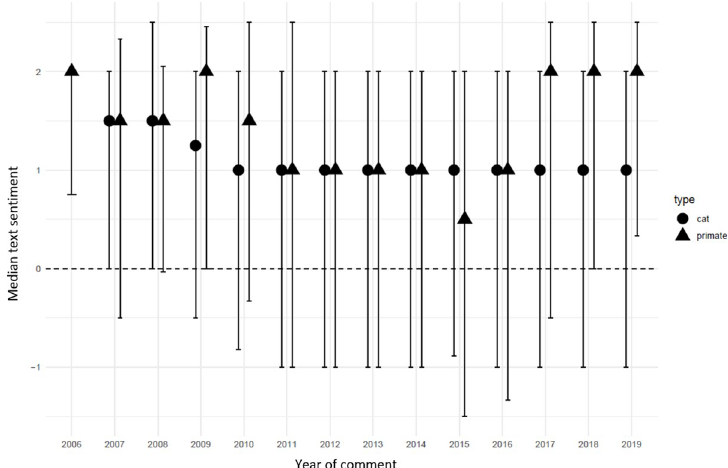
Fig 5. Median text and emoji sentiment over time of 346 exotic wild cats and primates YouTube 1 videos published between 2006 and 2019. Error bars represent first to third quartiles.